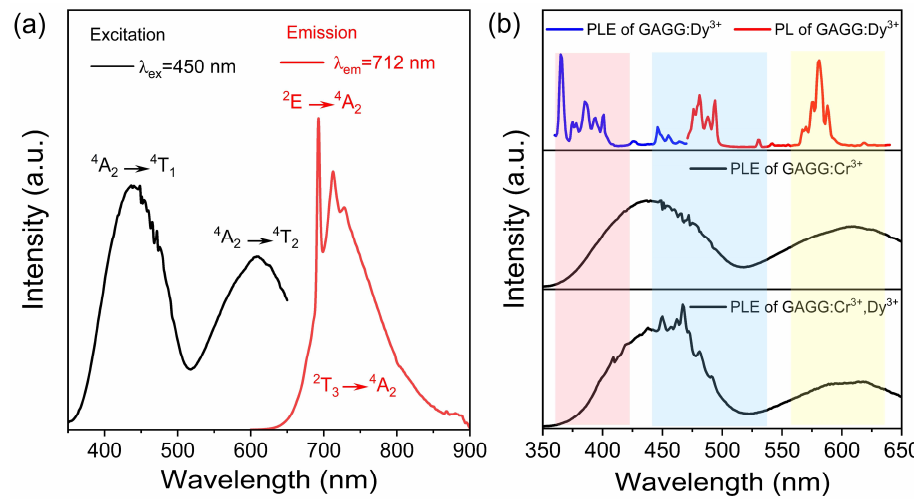
Figure 3. ( a ) PLE (λem = 712 nm) and PL (λex = 450 nm) spectra of GAGG:0.1Cr 3+ ; ( b ) PL spectrum of GAGG:Cr 3+ and GAGG:Cr 3+ , Dy 3+ (black line), the PL (Blue line) and PLE spectra (red line) of GAGG:Dy 3+ .